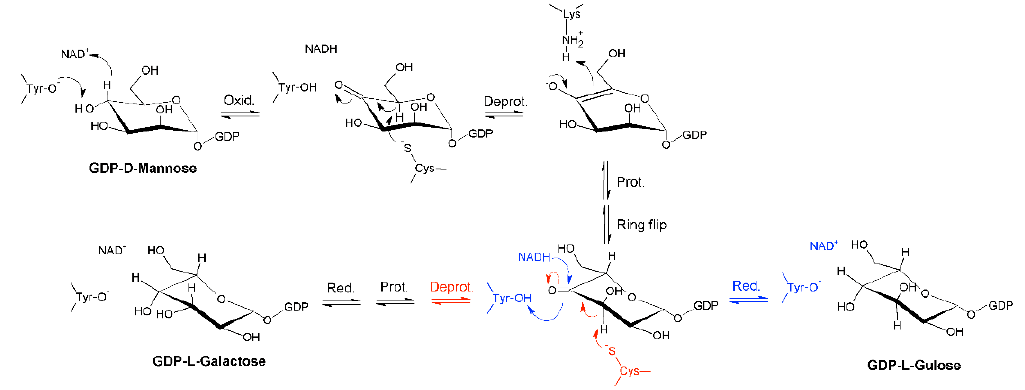
Figure 1. Mechanism of the GDP-mannose 3,5-epimerase. The epimerization reaction results in an equilibrium between GDP- D -mannose (GDP-Man), GDP- L -galactose (GDP-L-Gal), and GDP- L -gulose GDP-L-Gul.